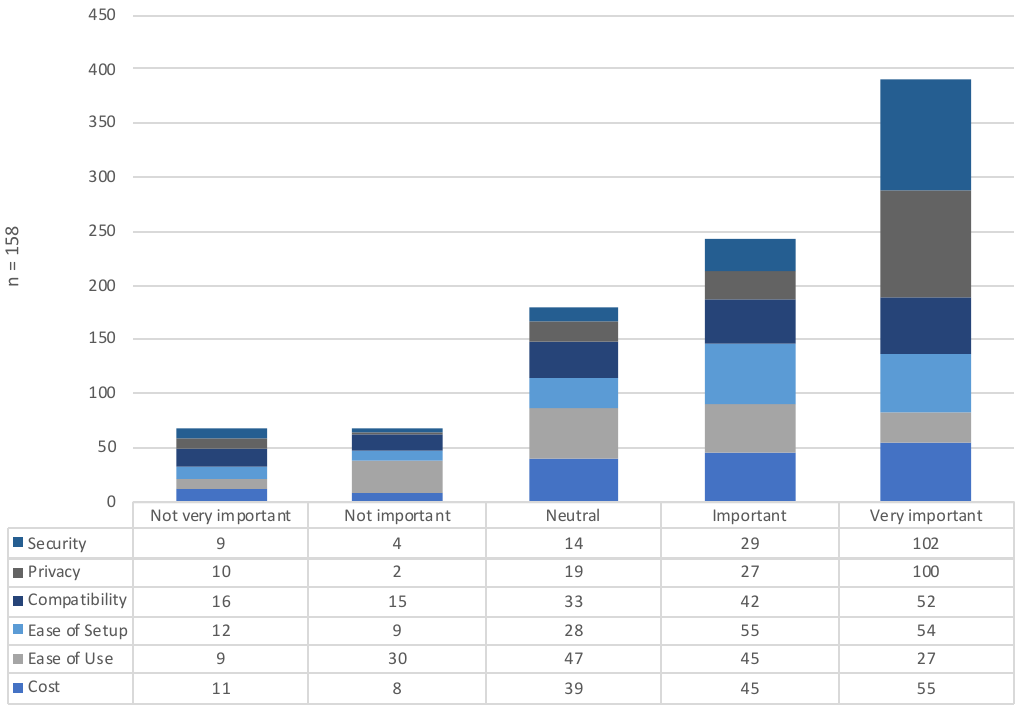
Figure 3. IoT device feature importance.